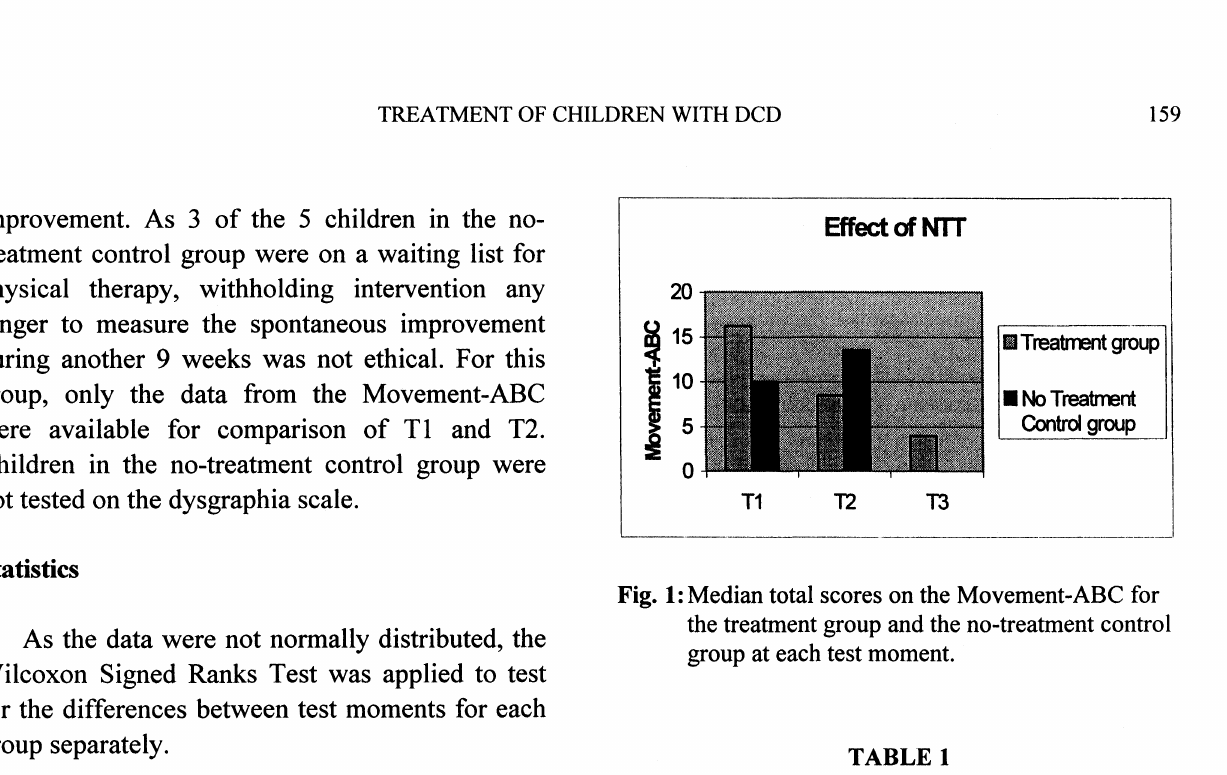
Performance of children in the intervention group in the Movement-ABC before and after